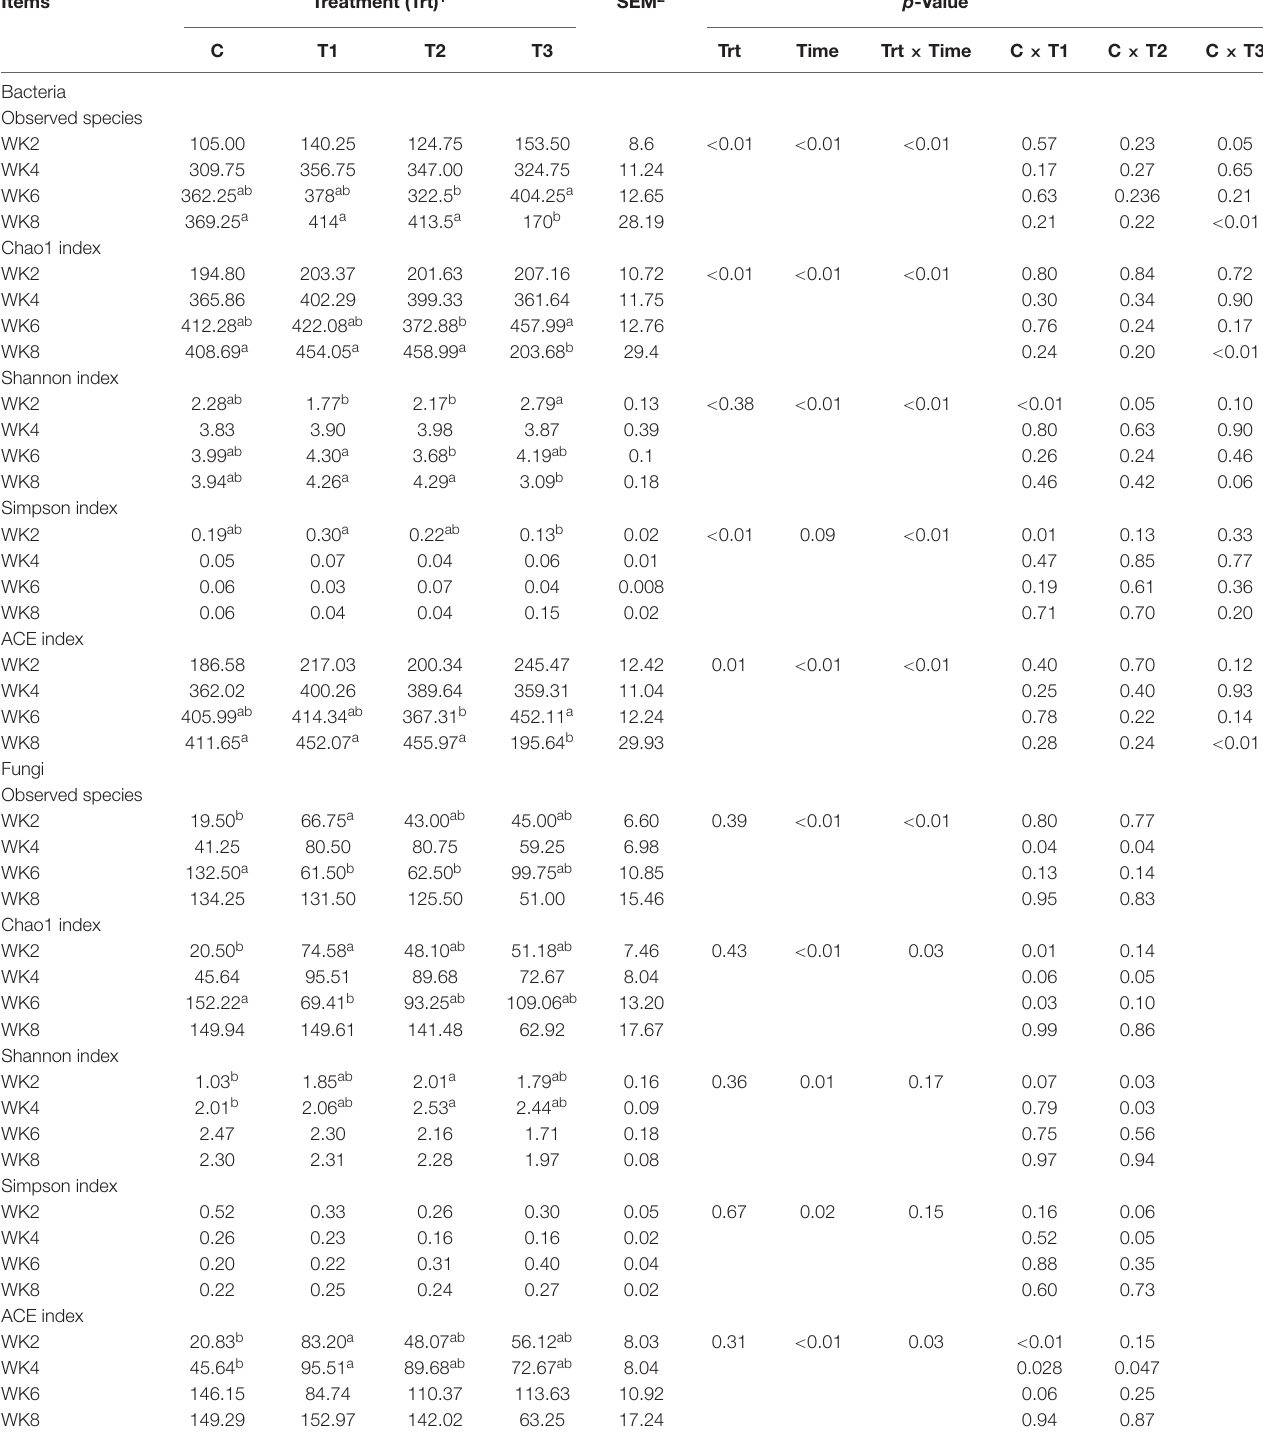
TABLE 4 | The abundance and diversity of microbial microbiota in Holstein dairy calves fed with different doses of multispecies probiotics. Items Treatment (Trt) 1 SEM 2 p -Value